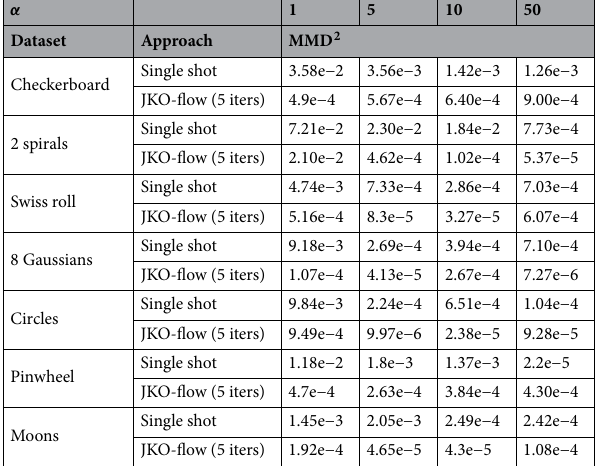
Table 1. Synthetic 2D data: JKO-flow performance for different values of α . JKO-flow returns consistent performance for different α